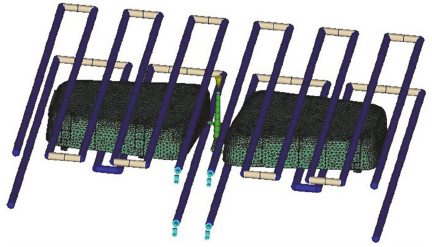
Figure 6: Simulation